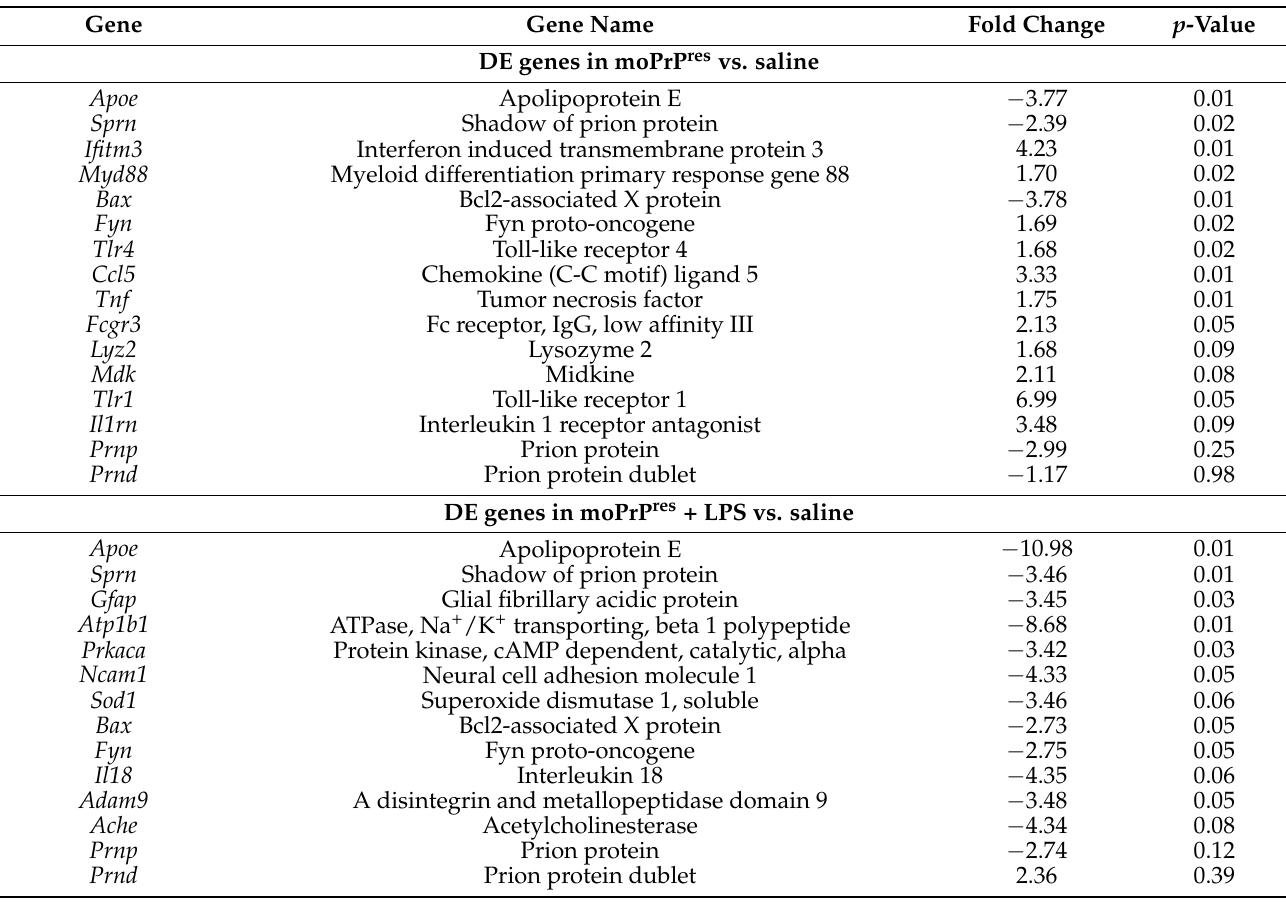
Table 3. List of differentially expressed genes in the brain tissue of terminally sick mice after subcutaneous injection